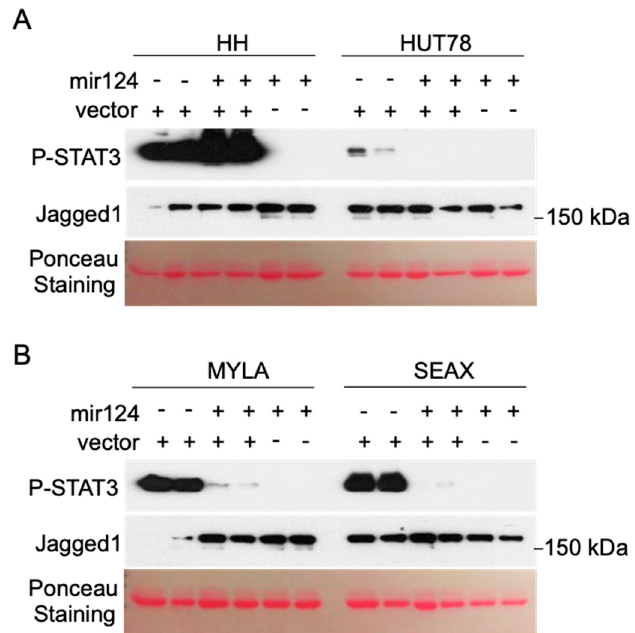
Figure 2. Ectopic expression of miR-124 precludes JAK/STAT3 signaling. Western blot analysis of p -STAT3 in HH, HUT78 (A), MYLA and SEAX (B) CTCL cell lines transduced with control vector, control vector plus lentiviral miR-124 expression vector, or miR-124 vector alone. Two biological replicates of each condition are included. Levels of the Notch1 ligand Jagged1 are shown as negative control of miR-124-dependent regulation. It is worth mentioning that the combination of control virus and miR-124 in HH (A) did not produce any effect on p-STAT3 likely due to dilution of the miR-124 lentivirus.